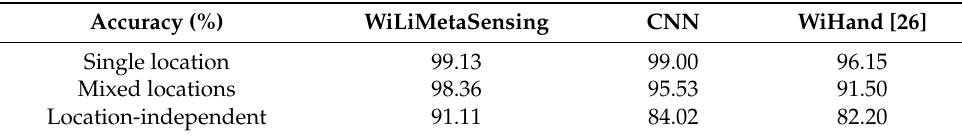
Table 2. The recognition accuracy for single location sensing, mixed locations sensing, and location- independent sensing.